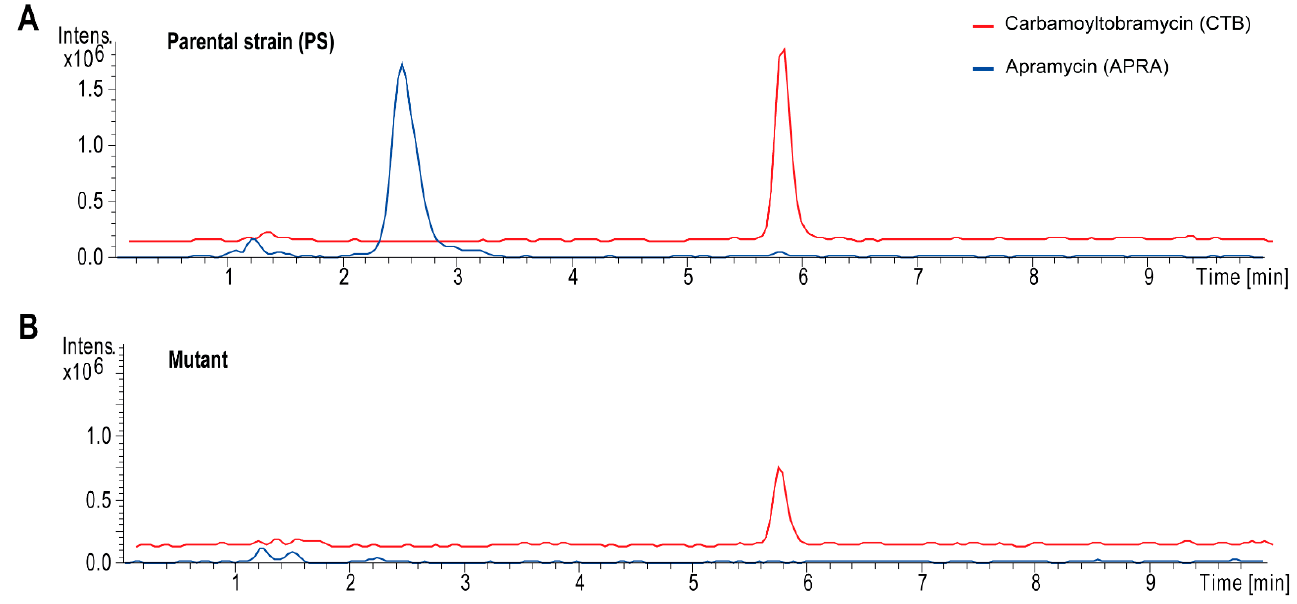
Figure 5. Extracted ion chromatograms for apramycin (APRA) ( m / z [M + Na] + = 562) and carbamoyltobramycin (CTB) ( m / z [M + Na] + = 533). ( A ) Streptoalloteichus tenebrarius 2444 parental strain (PS). ( B ) Gene knockout mutant ∆ aprK .